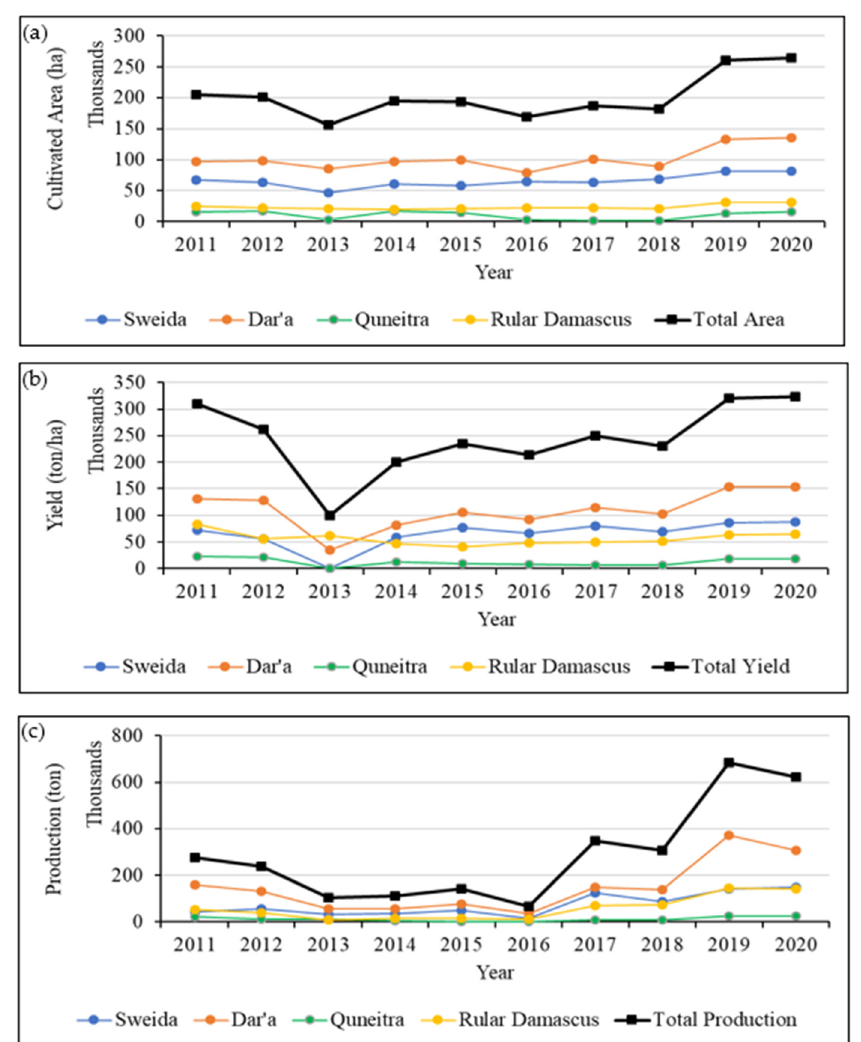
Figure 8. Statistics of ( a ) the total cultivated area, ( b ) crop yield, and ( c ) agricultural production in Dara’a, Quneitra, As-Sweida, Quneitra, and Rural Damascus governorates in the Syrian part of YRB (Data Source: Syrian Ministry of Agriculture).